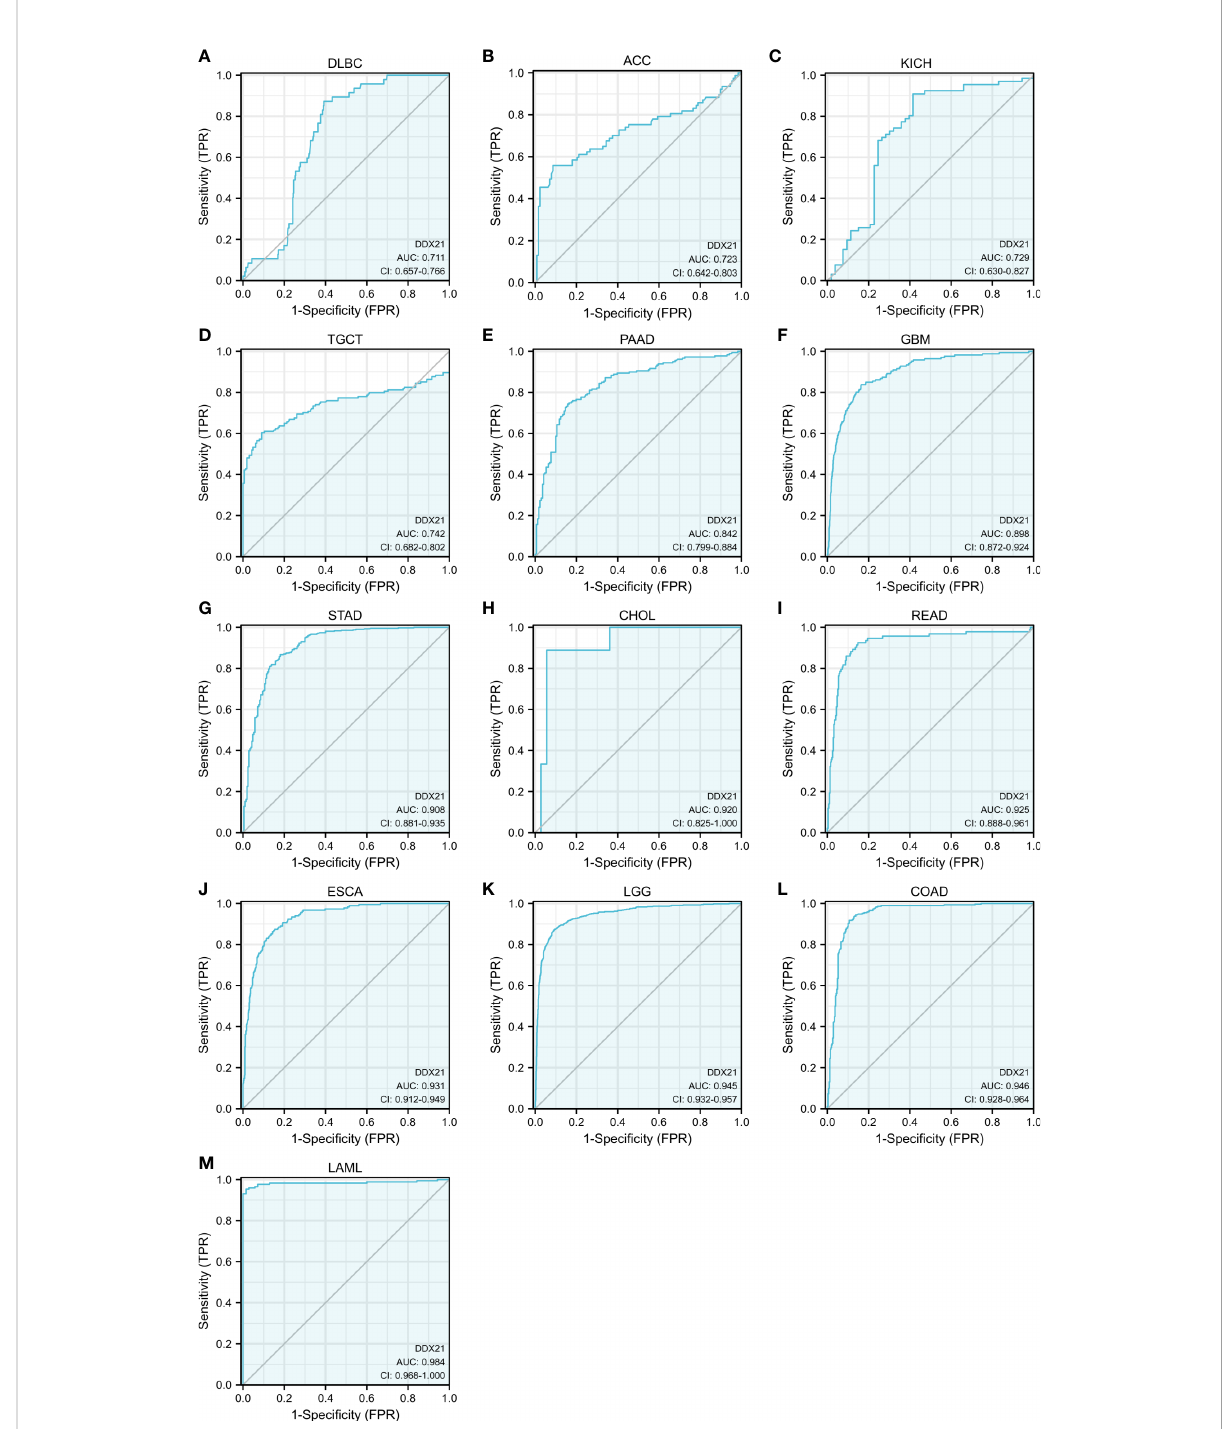
FIGURE 5 Analysis of receiver operating characteristics (ROC) curves between DDX21 and tumor prognosis based on data from TCGA and GTEx databases. (A – M) The area under the ROC curve (AUC) for lymphoid neoplasm diffuse large B-cell lymphoma (DLBC), adrenocortical carcinoma (ACC), kidney chromophobe (KICH), testicular germ cell tumors (TGCT), pancreatic adenocarcinoma (PAAD), glioblastoma multiforme (GBM), stomach adenocarcinoma (STAD), cholangiocarcinoma (CHOL), rectum adenocarcinoma (READ), esophageal carcinoma (ESCA), brain lower-grade glioma (LGG), colon adenocarcinoma (COAD), and acute myeloid leukemia (LAML) was 0.711, 0.723, 0.729, 0.742, 0.842, 0.898, 0.908, 0.920, 0.925, 0.931, 0.945, 0.946, and 0.984, respectively, indicating a high predictive value for tumor